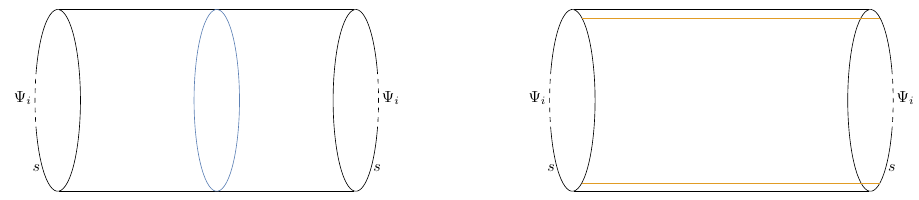
Figure 5 . The “boundary necklace” channel (left) and the “boundary bagel” channel (right) of the cylinder two-point function with identical boundary operators and identical boundary conditions on each